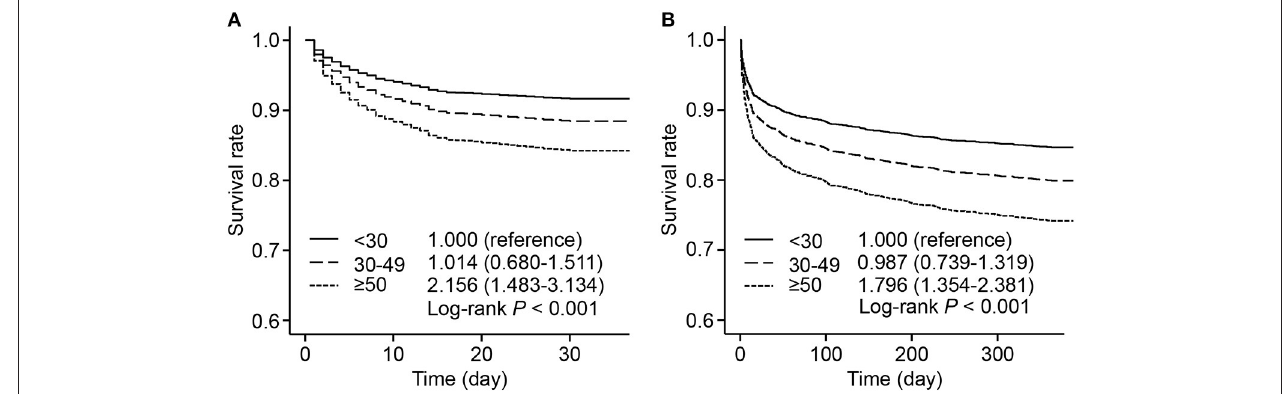
FIGURE 2 | Adjusted survival rate by 3 HR fluctuation groups. Survive curves presented adjusted survival rates of 30-day mortality (A) and 1-year mortality (B) by 3 HR fluctuation groups. Adjusted variables included age, male sex, weight, SOFA score, admission HR, sedative use, ventilation use, vasopressor use, CHF, AF, hypertension, and liver disease, namely, model 5 described above. The hazard ratio and 95% CI were calculated compared with those of the low HR fluctuation group. HR, heart rate; SOFA, sequential organ failure assessment; CHF, congestive heart failure; AF, atrial fibrillation; CI, confidence interval.